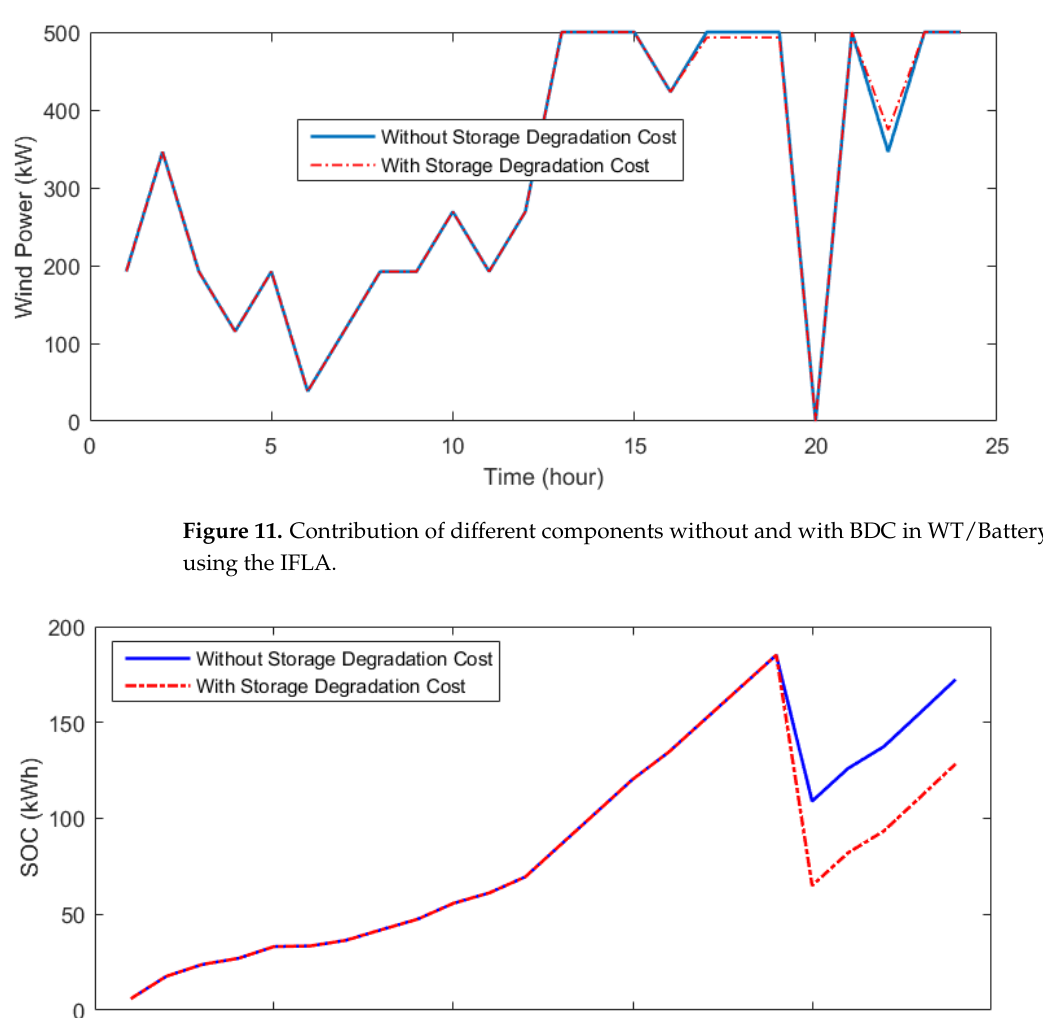
Figure 13. Power losses of the network without and with BDC in WT/Battery scheduling using the IFLA.